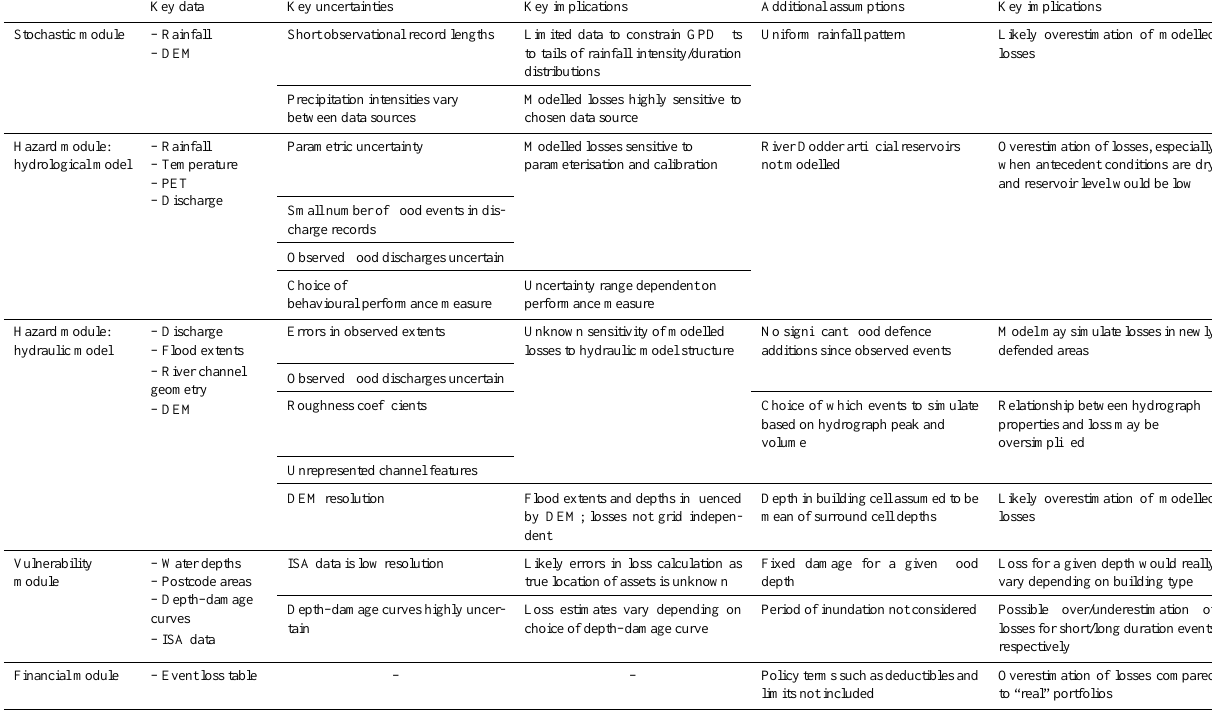
Table 1. Table showing the required data sources for each module, along with key uncertainties, assumptions and their respective implications for modelled losses. DEM: Digital Elevation Model, PET: Potential Evapotranspiration, ISA: Impervious Surface